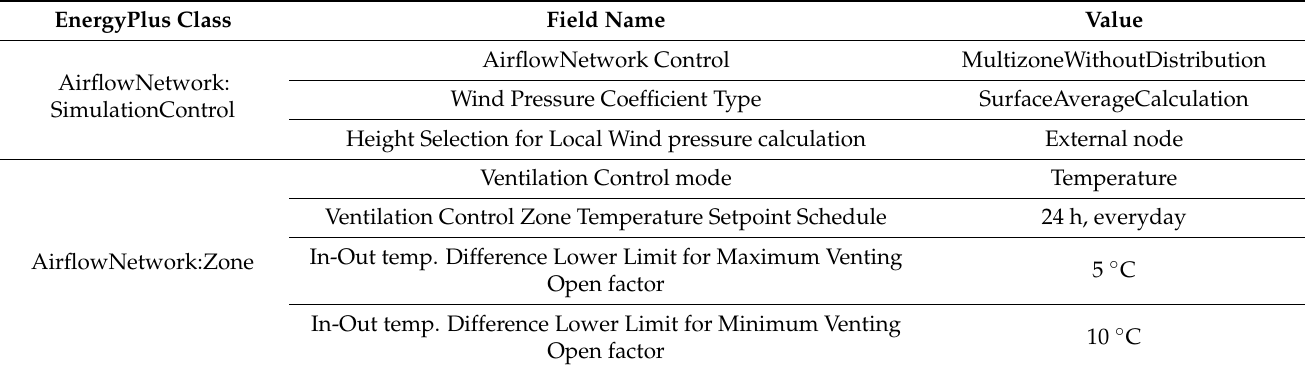
Table 4. EnergyPlus hybrid ventilation modeling input parameters (Airflow